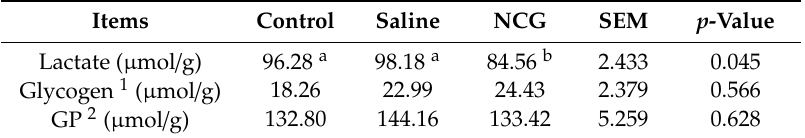
Table 4. Glycolytic potential of pectoral muscle in